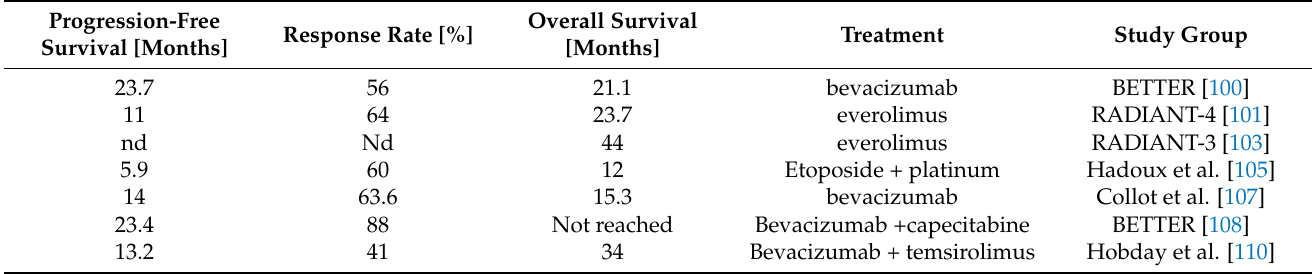
Table 2. Results of chemotherapy in GEP